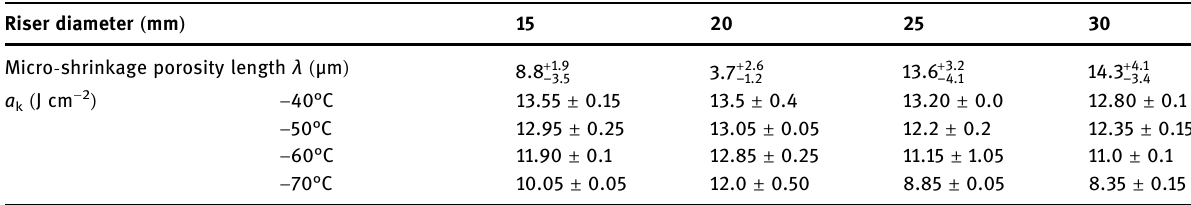
Table 2: Test results of impact energy of triangular micro - shrinkage porosity with di ff erent sizes